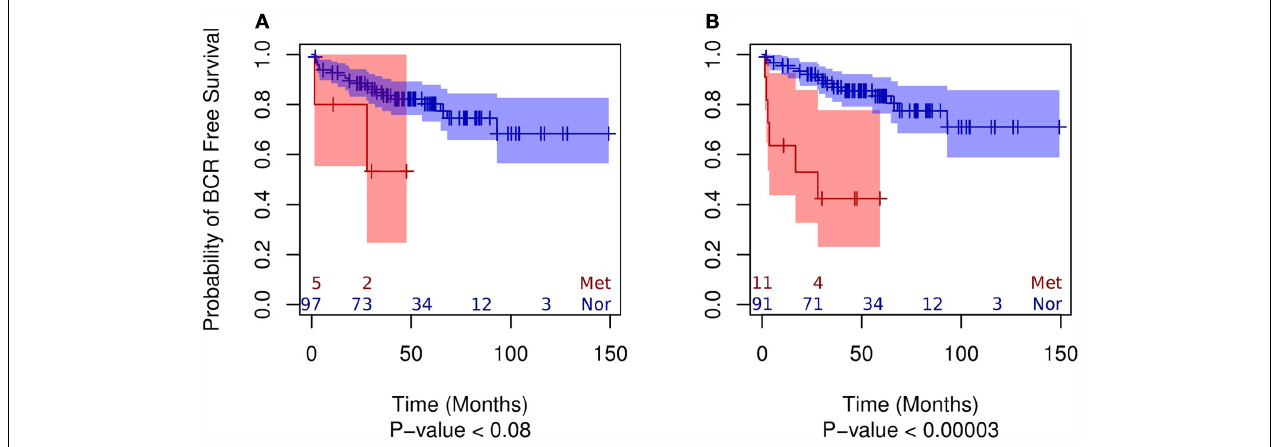
FIGURE 3 | Kaplan–Meier plots of the two groups of primary tumor samples classified by KNN (“normal-like”vs. “metastatic-like”) using the BCR end point for exonic (A) and non-exonic (B) features.